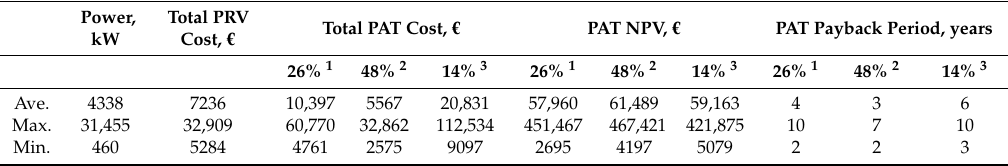
Table 2. PRV / PAT analysis in case study